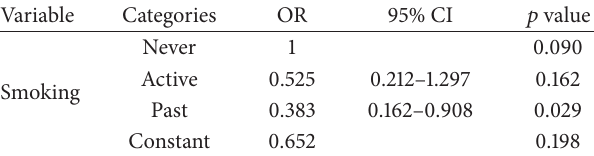
Table 11: Multivariate analysis: PD-L1 positive